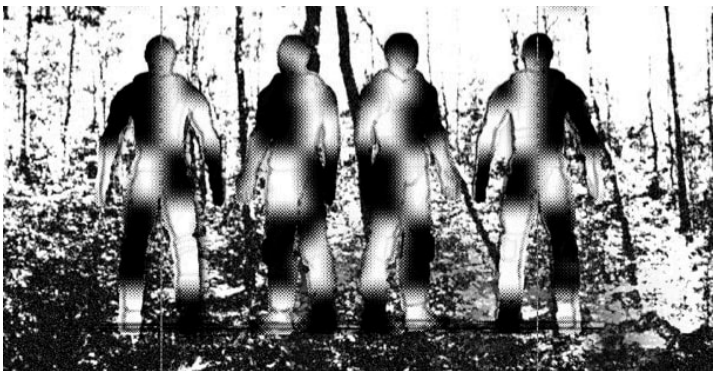
Figure 6. Example of determining the micro scale of a pattern on human silhouette